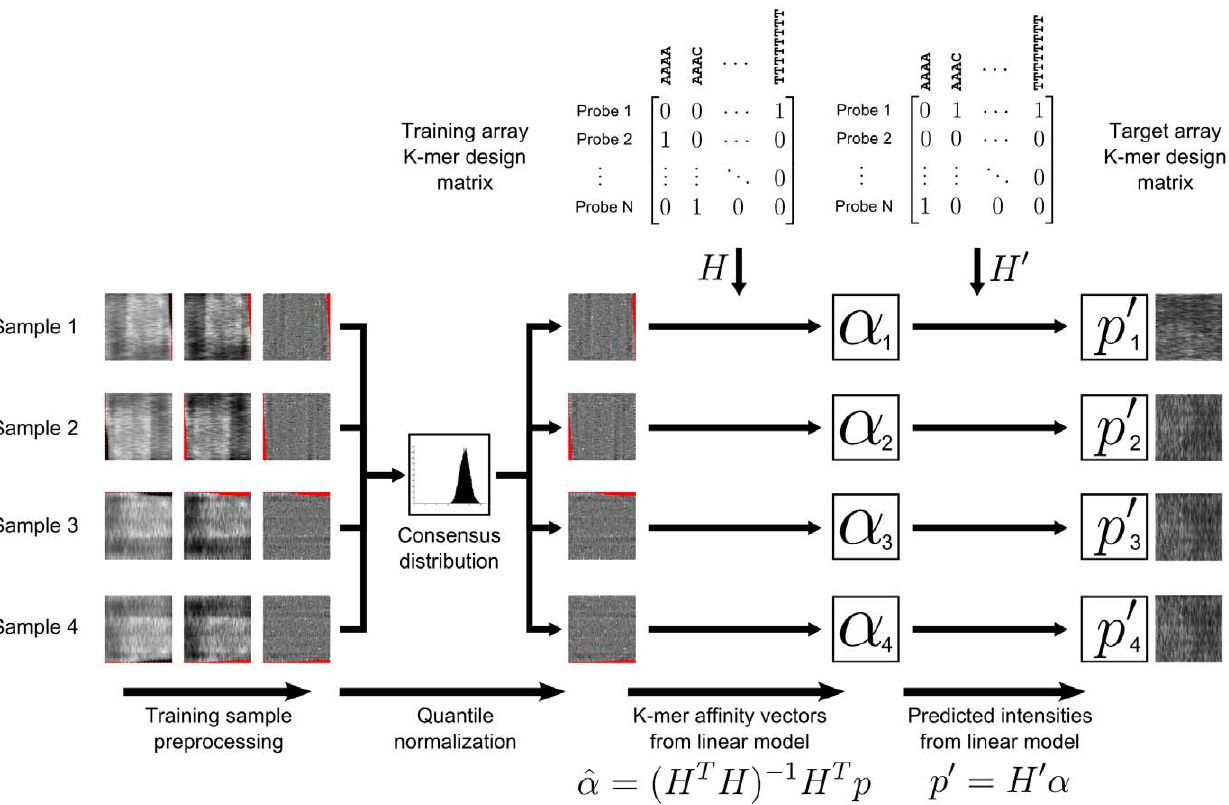
Figure 3. Overview of the full binding intensity prediction model. PBM samples are first preprocessed by removing dark outlier probes and performing spatial detrending. The samples are then quantile normalized before application of the linear model. In this example, the predicted binding intensities are shown to be calculated against probe sequences on another PBM array, but could just as well be calculated for genomic sequences or any other DNA sequences.